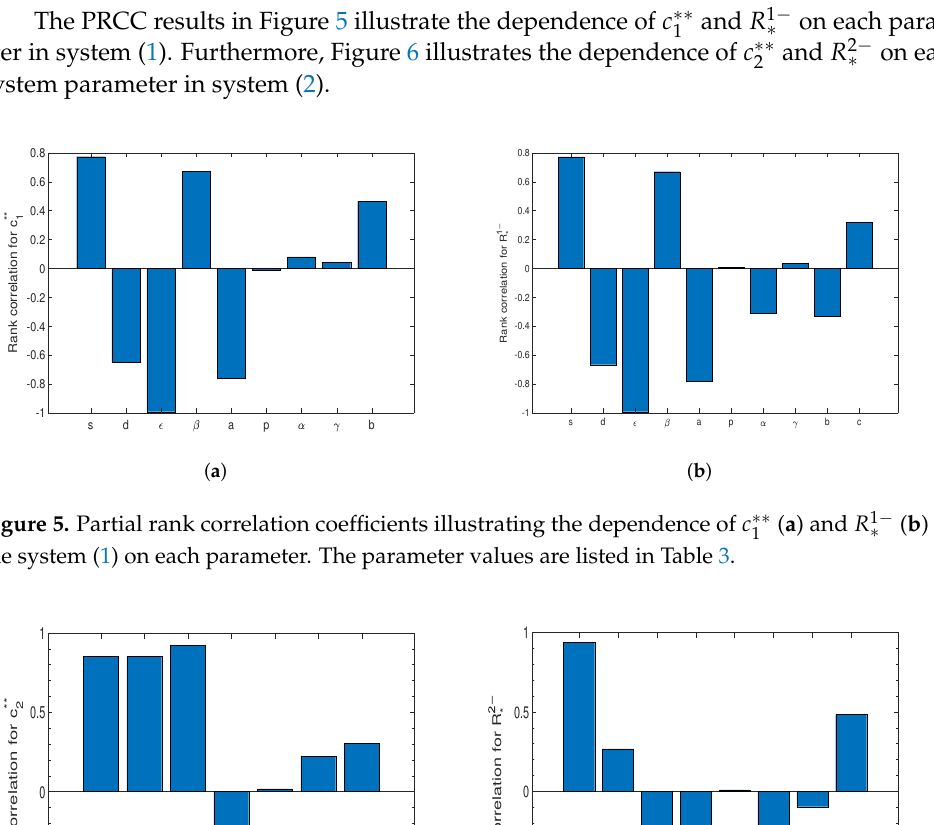
( a ) and R 2 − ∗ ( b ) for 2